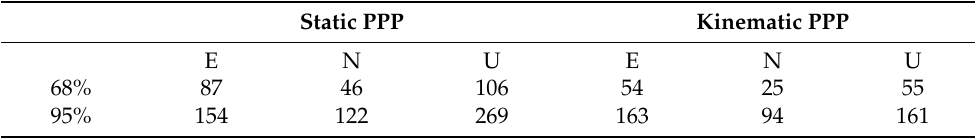
Table 15. Convergence time of the EG method (unit: min) (R/B/E). Static PPP Kinematic PPP